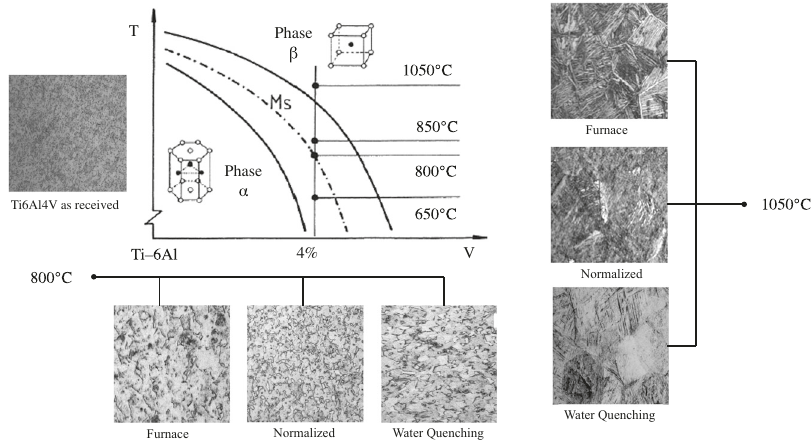
Fig. 1 Ti6Al4V alloy phase diagram [27, 28, 39,